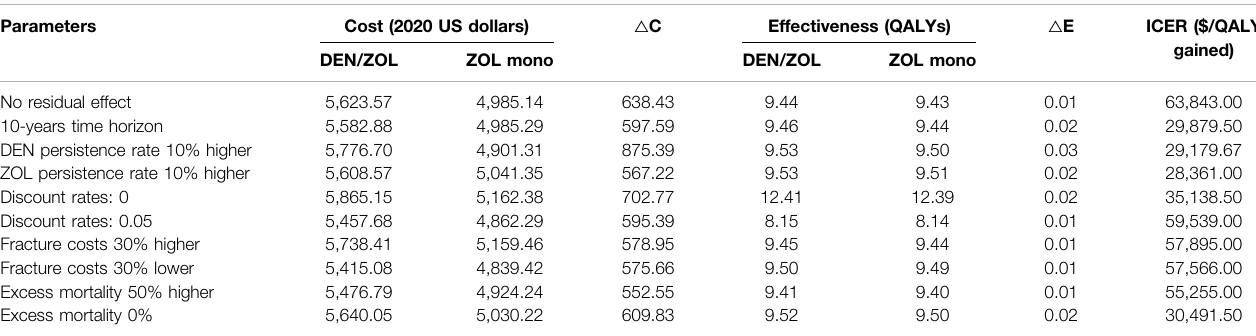
TABLE 2 | Results of one-way analyses at 65 years.